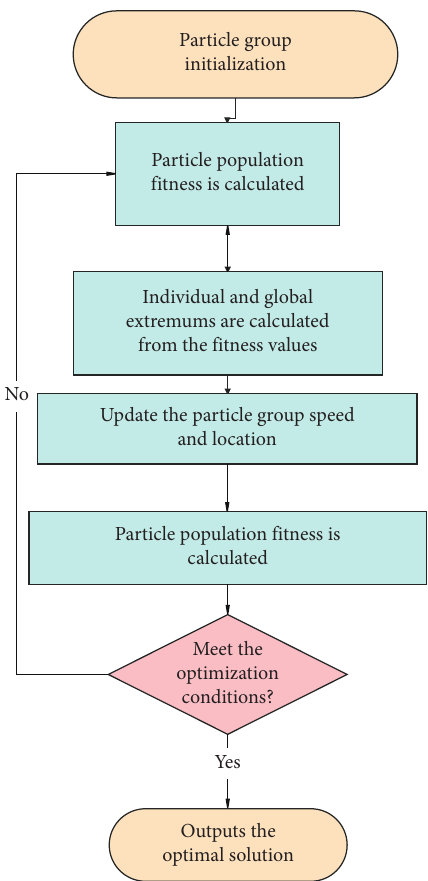
Figure 1: Flowchart of the standard particle swarm optimization